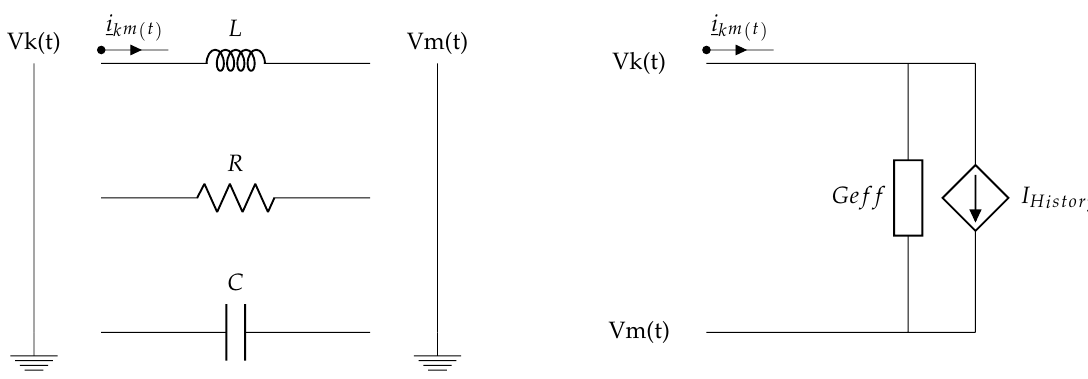
Figure 3. Numerical Integration Substitution (NIS) method